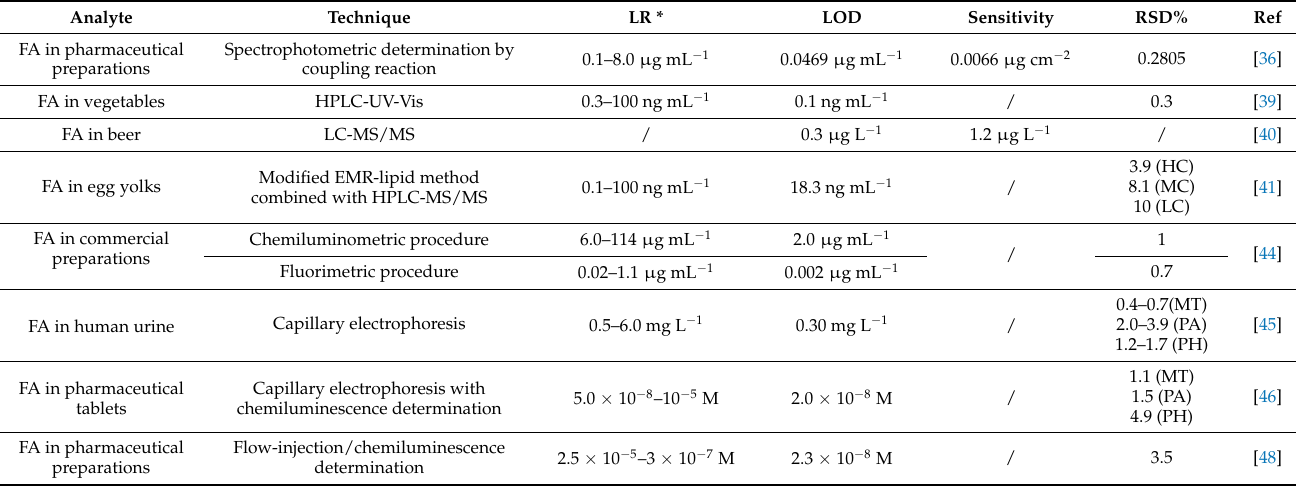
Table 1. Summary of analytical methods for the determination of FA in various